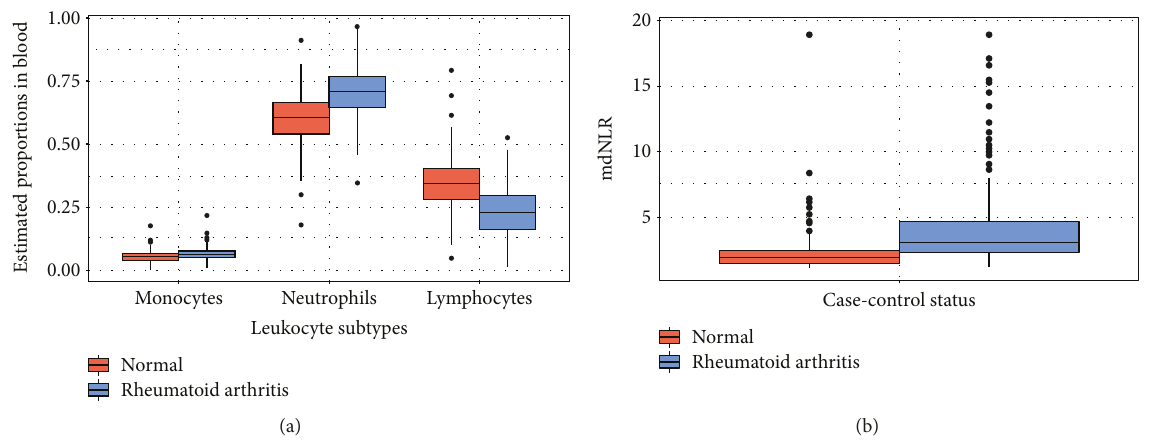
Figure 2: Leukocyte cell subtypes and mdNLR in new onset RA cases and controls. (a) Estimated proportions of leukocyte subtypes (monocytes, neutrophils, and lymphocytes) in controls and new onset RA cases. (b) Higher mdNLR SI index in new onset RA cases compared to controls ( P < 2 2 e − 16